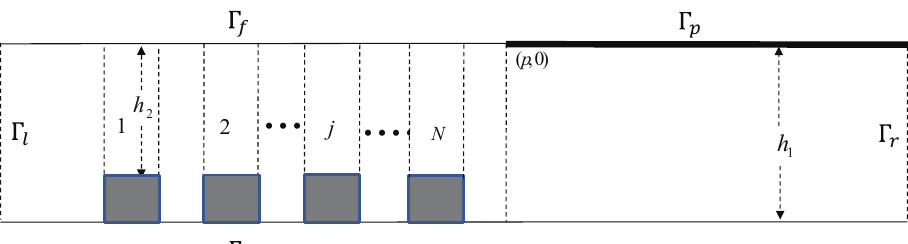
Figure 2. Computational domain for